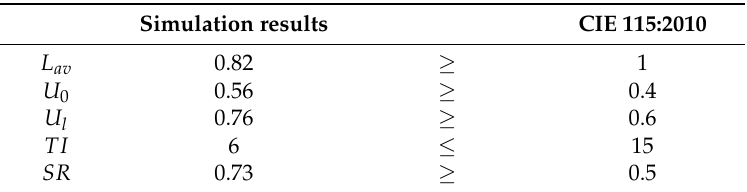
Table 5. Average luminance ( L av ), overall uniformity of luminance ( U 0 ), longitudinal uniformity of luminance ( U l ), threshold increment ( TI ) and surround ratio ( SR ) of the road between Lamp 6 and Lamp 7 of the